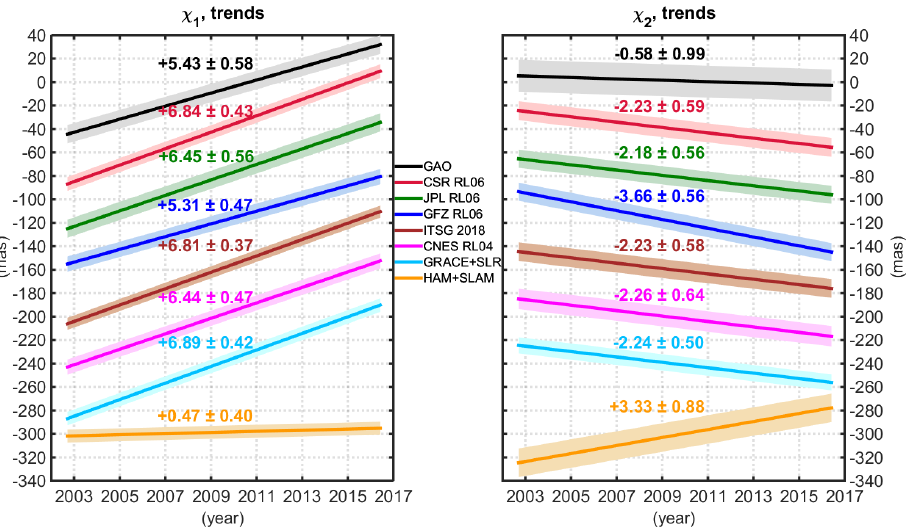
Figure 6. Trends in χ 1 and χ 2 components of GAO, GSMAM, GRACE + SLR, and HAM + SLAM together with their errors. The shades show the errors of trends determined. The values are given in mas/year.